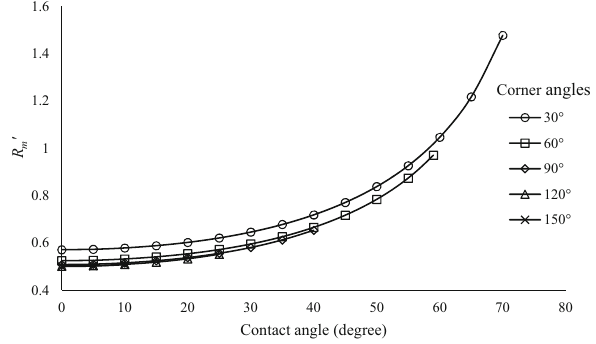
, for different equilateral R